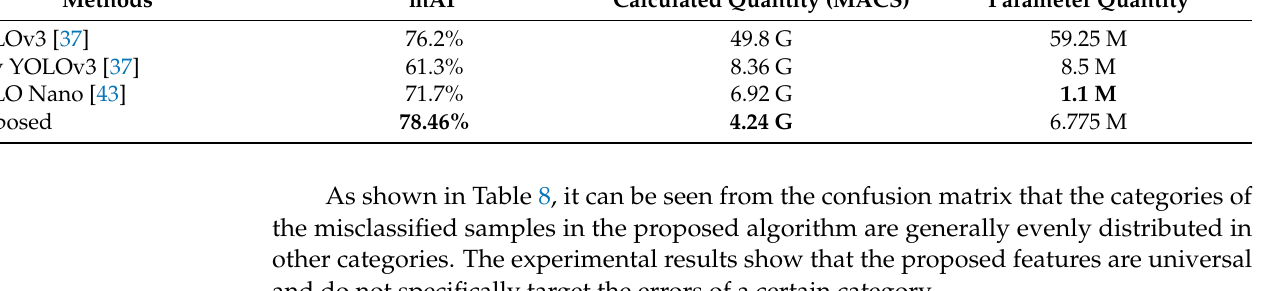
Table 7. Comparison of accuracy, calculation, and parameters between this model and other network models. Methods